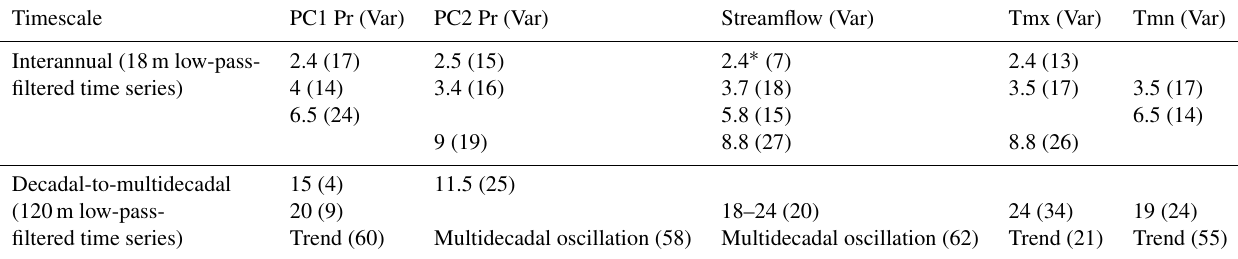
Table 2. Leading frequencies (in years) of regional precipitation patterns, monthly mean streamflow of the Paraná River, and area-averaged maximum and minimum temperature (Tmx and Tmn). Precipitation is represented by the two leading patterns of the PCA for both 18- and 120-month filtered fields. All streamflow modes were noted in Corrientes and Timbúes gauging stations, except the near-biannual cycle ( ∗ ) that is only shown in Timbúes. The percentage of variance explained by each mode is given in parentheses. Timescale PC1 Pr